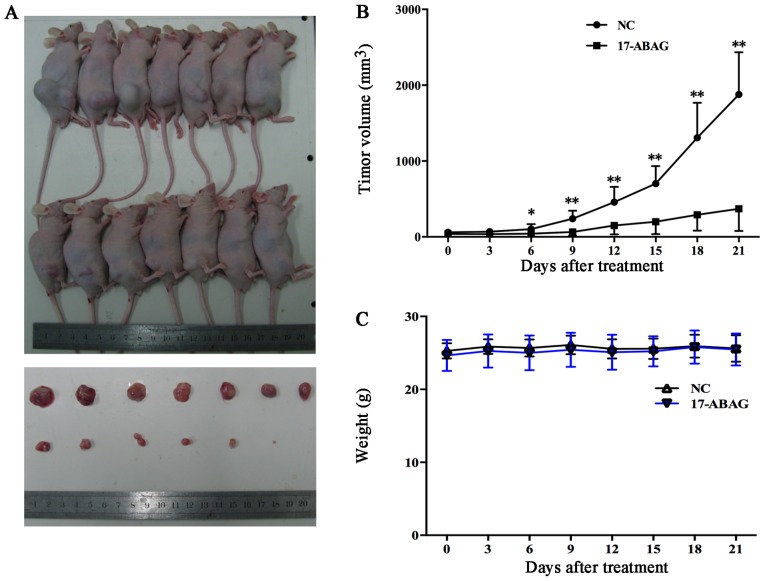
17-ABAG significantly delays LNCaP tumor growth. (A) 17-ABAG inhibits the growth of LNCaP xenograft tumors in mice. Upper panel, images of tumor-bearing mice with (bottom row) or without (top row) 17-ABAG treatment. Lower panel, images of extracted LNCaP tumors with (bottom row) or without (top row) 17-ABAG treatment. (B) Tumor volume of the mice. The animals treated with 17-ABAG exhibited a significant decrease in average tumor volume compared with that in the control mice from day six onwards. *P<0.05. (C) Body weight of the mice. P>0.05 (17-ABAG treated vs. control). Values are expressed as the mean ± standard error of the mean (n=7). (D) HE staining and anti-Ki67 immunohistological staining analysis of tumor sections from the mice (magnification, ×200). (E) HE-stained sections of the heart, liver, spleen, lung and kidney of the mice (magnification, ×200). HE, hematoxylin and eosin; NC, negative control.